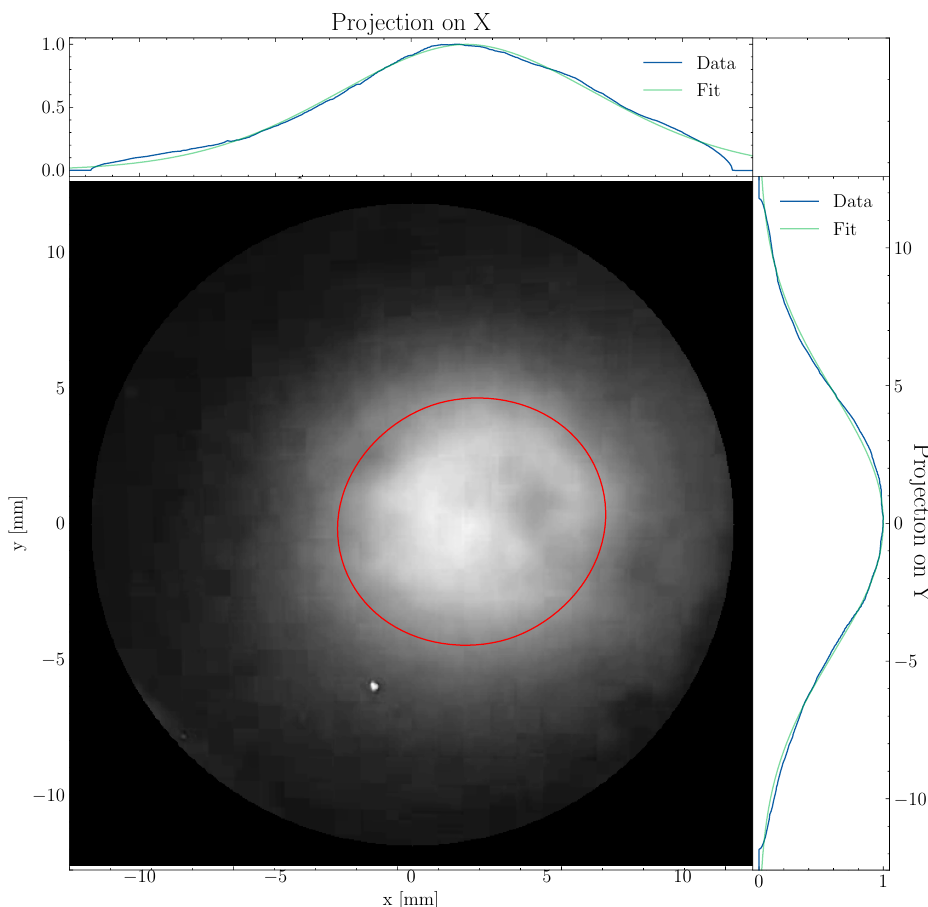
Figure 6. 2D image of the beam, where the ellipse corresponds to the 1 σ contour. The x and the y projections fitted by a generalized Gaussian curve are